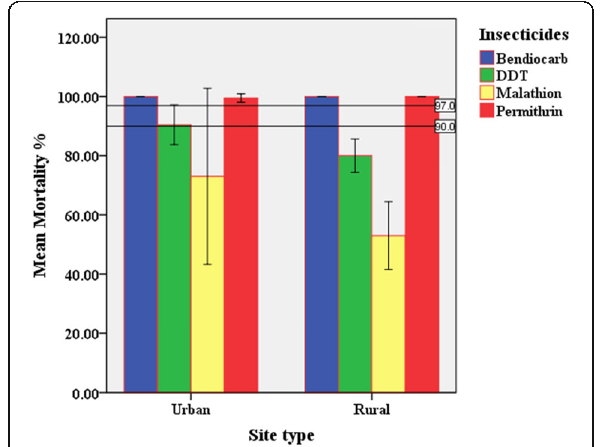
Fig. 2 Mean mortality rates of Anopheles arabiensis exposure to bendiocarb, DDT, malathion, and permethrin. Mortality rates according to different sampling sites. Bars show mean mortality with standard deviation (SD). Solid horizontal lines show the WHO mortality threshold for the definition of resistant mosquito